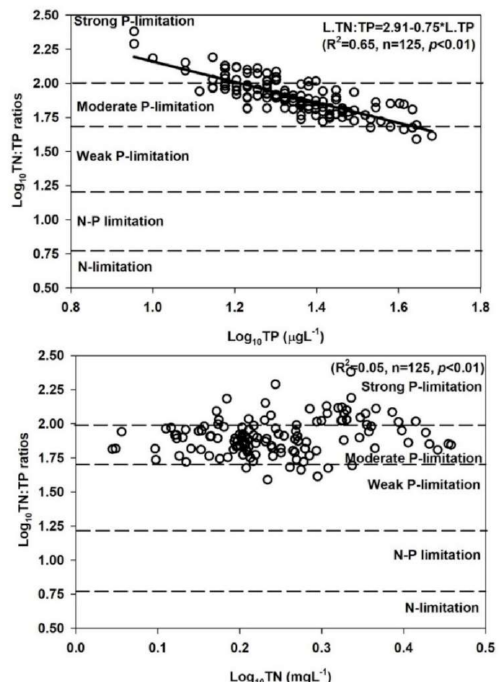
Figure 7. Determination of limiting nutrient based on empirical modeling on the TN:TP ratios, TP, and TN. TP: total phosphorus; TN: total nitrogen.